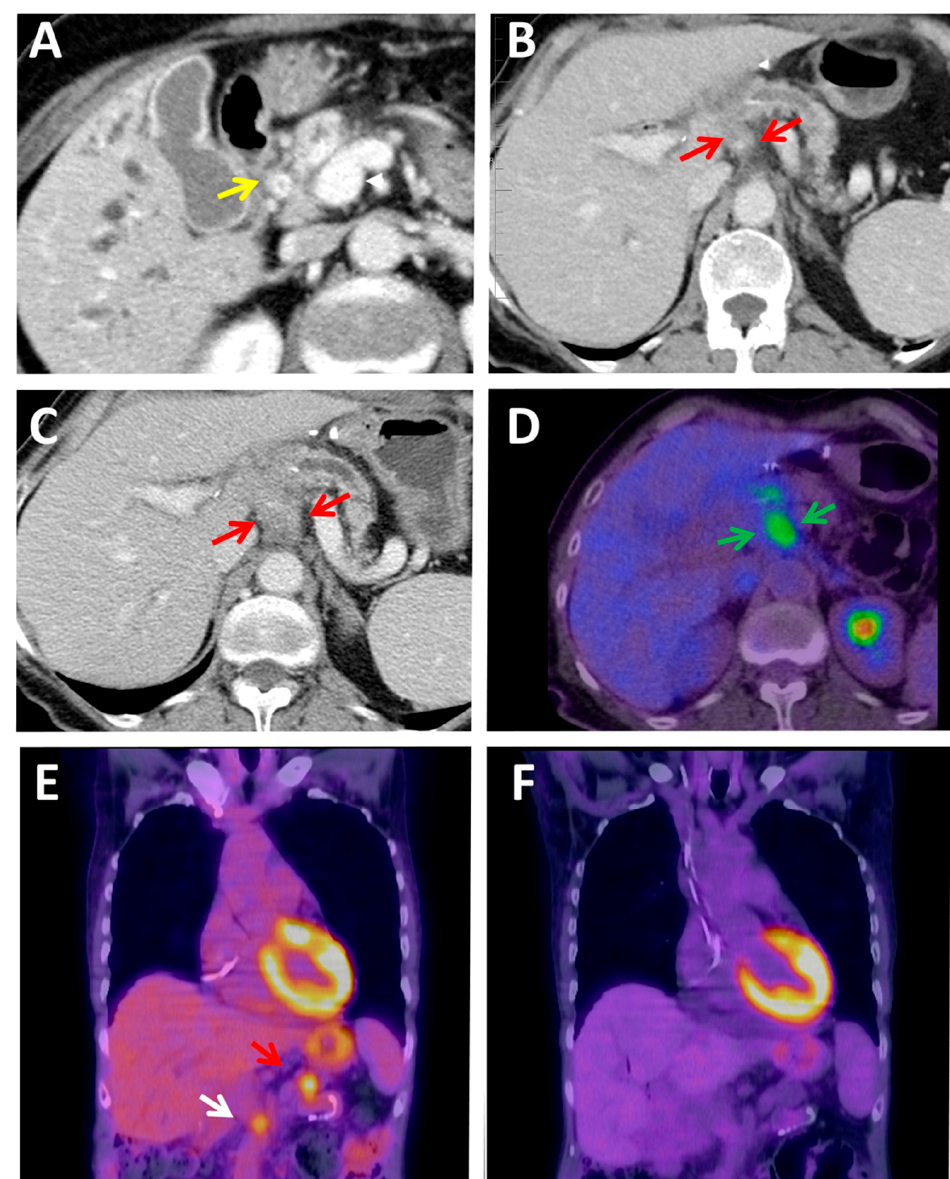
Figure 3. Local inflammatory and fibrotic changes at the surgical site and treatment response eval- uation are diagnostics challenge for radiologists. ( A – D ) A case of local inflammatory and fibrotic changes at the surgical site are a diagnostic challenge for radiologists. A PDAC was suspected because of a bile duct stricture ( A ) (yellow arrow). The tumor was surgically resected; the pathology report showed a stage I cancer, pT1c pN0 M0 R1 (retroperitoneal margin was microscopically affected). Findings in a CT performed two months after surgery required a differential diagnosis between benign fibrotic tissue at the surgical site and a retroperitoneal tumor relapse (red arrows). The increasing tissue size (red arrows) in a consecutive 1-month later performed CT ( C ) and the mod- erately high 3.67 SUVmax found in an [ 18 F]FDG PET–CT ( D ) finally made the diagnosis of relapsed PDAC, and a palliative combination chemotherapy regimen was initiated. ( E , F ) [ 18 F]FDG PET PDAC treatment response evaluation. ( E ) PDAC relapsed at the surgery site (15 mm, 5.73 SUVmax) (red arrow) and metastatic lymph node in the superior mesenteric vein area (10 mm, 4.0 SUVmax) (white arrow). ( F ) Early complete metabolic response after two cycles of